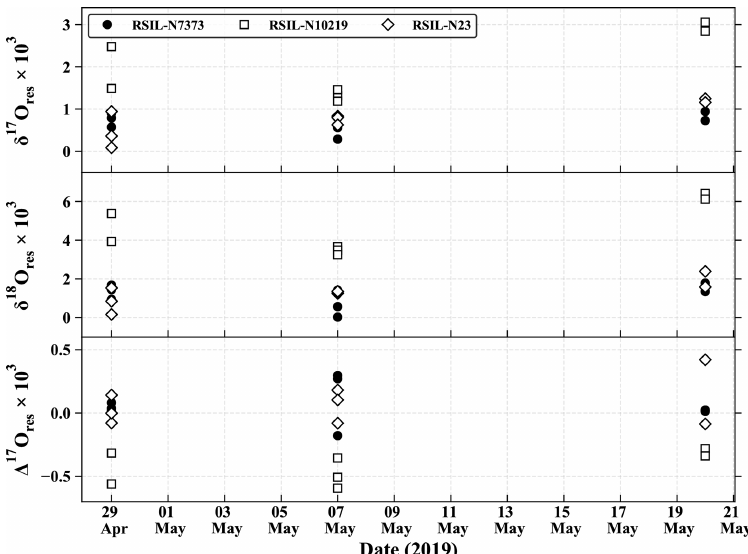
Figure B1. Temporal evolution of δ 17 O ,δ 18 O, and ∆ 17 O differences between our measurements of RSIL standards (prepared in the KOH/guaiacol eluted matrix) and their certified reference values. Error bars derived from measurement uncertainties are approximately equivalent to the size of the